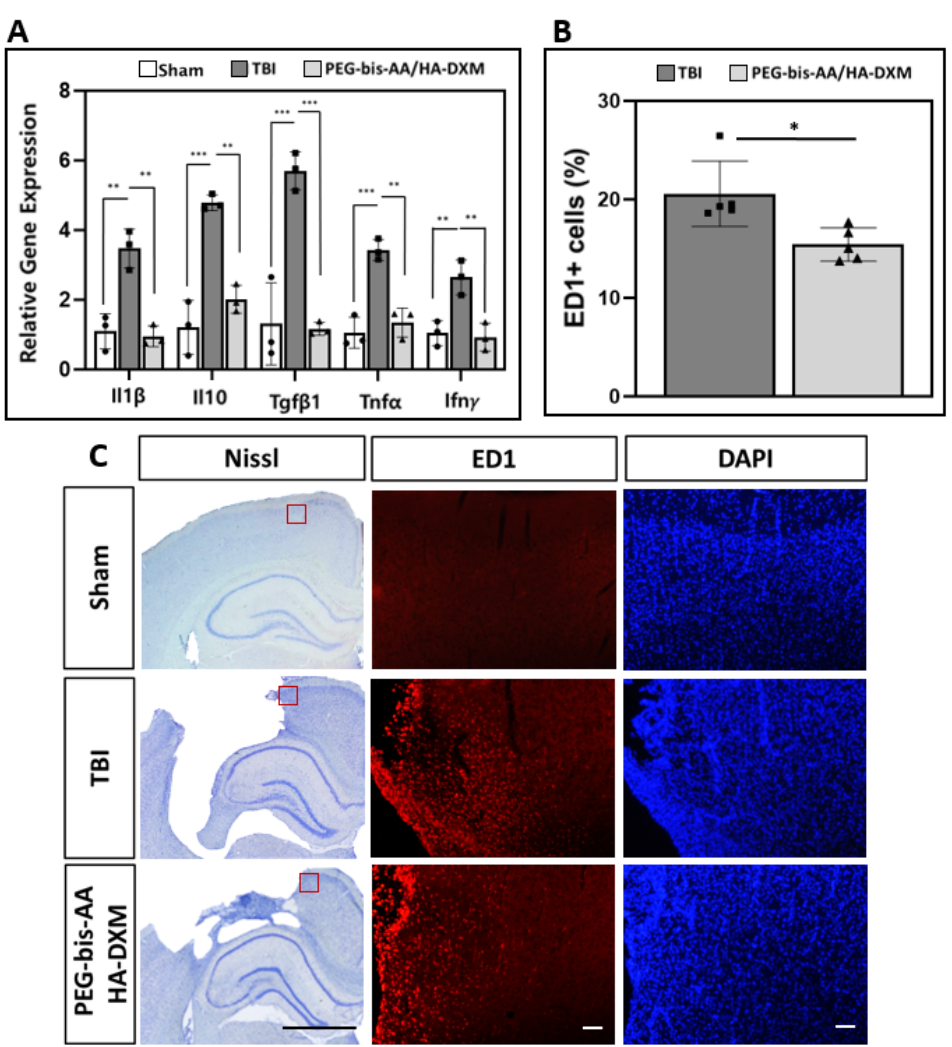
Figure 4. The effect of PEG-bis-AA/HA-DXM treatment on the neuroinflammatory response at 14 DPI. ( A ) The mRNA expression of the inflammatory cytokines IL1 β , IL10 , TGF β 1 , TNF α , and Ifn γ . GAPDH was used as an endogenous control, and expression levels were calculated by the 2 − ∆∆ Ct method ( n = 3 rats/group). ( B ) The average percentage of ED1 + -activated microglia/macrophages to total DAPI + nuclei ( n = 3 sections/rat, n = 5 rats/group). Data are presented as mean ± STD. * p < 0.05, ** p < 0.01, *** p < 0.001 compared with TBI. ( C ) Representative images of ED1 + activated microglia/macrophages in the in ipsilateral cortex. Images are captured in the region indicated by the red box in the Nissl -stained brain section (black scale bar represents 2 mm). White scale bars represent 100 µm.